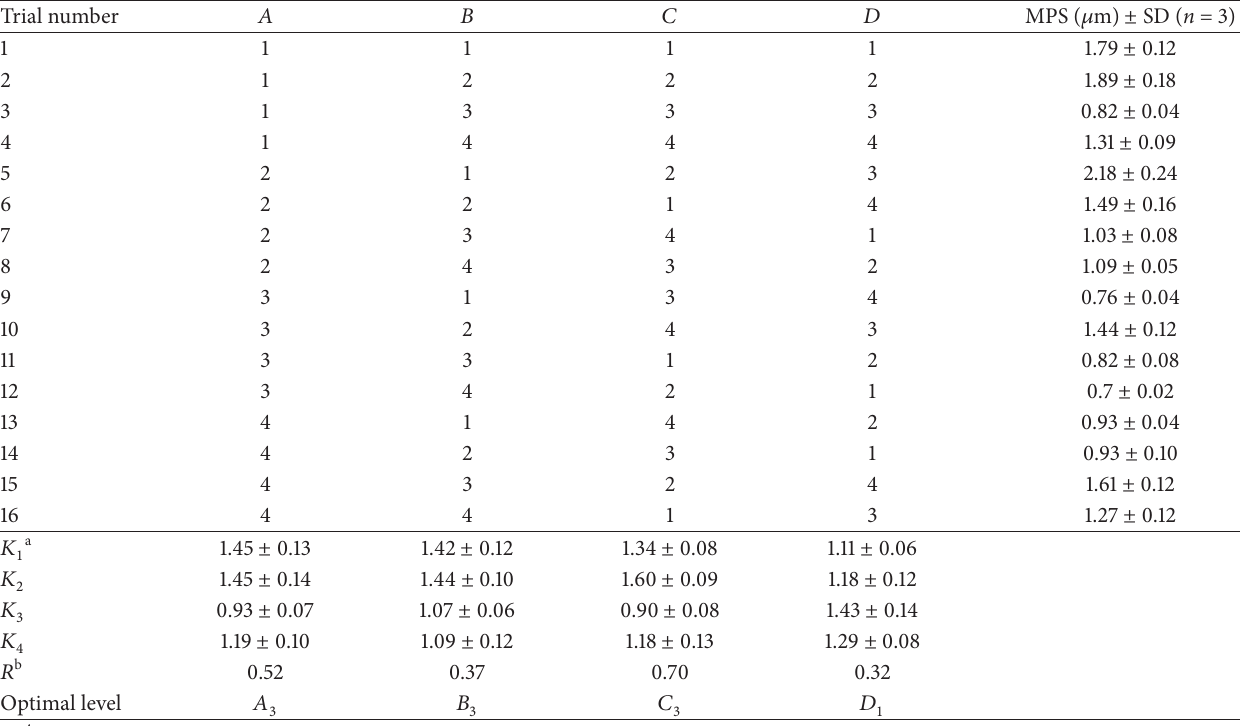
Table 2: Orthogonal array design OA16 (4) 5 and experimental